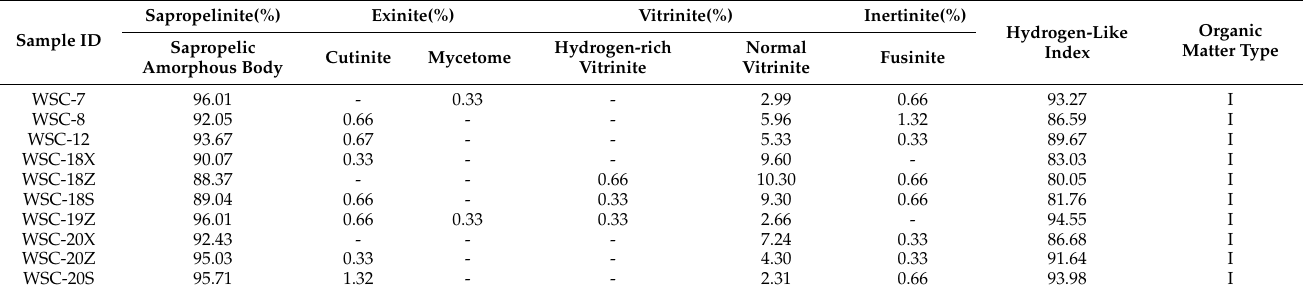
Table 4. Kerogen maceral results of lower Cambrian Niutitang formation black shale in Wenshuicun, Guizhou. Sample ID